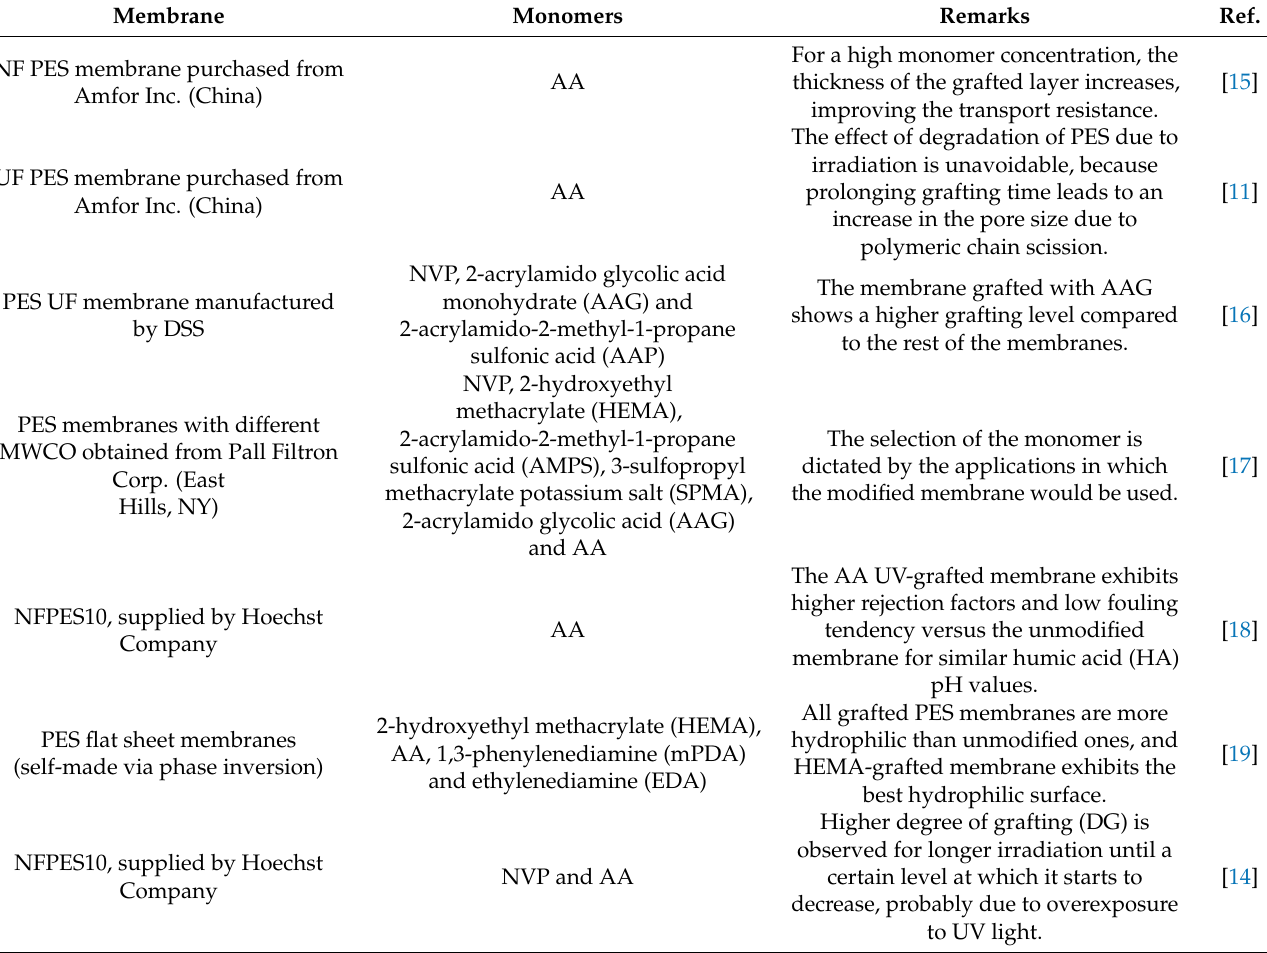
Table 1. Summary of research studies on the UV-grafted polyether sulfone (PES) membrane for FO, nanofiltration (NF) and ultrafiltration (UF)